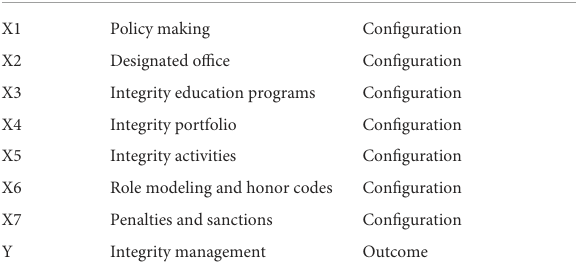
TABLE 1 Variable design for factors influencing integrity education of Chinese college